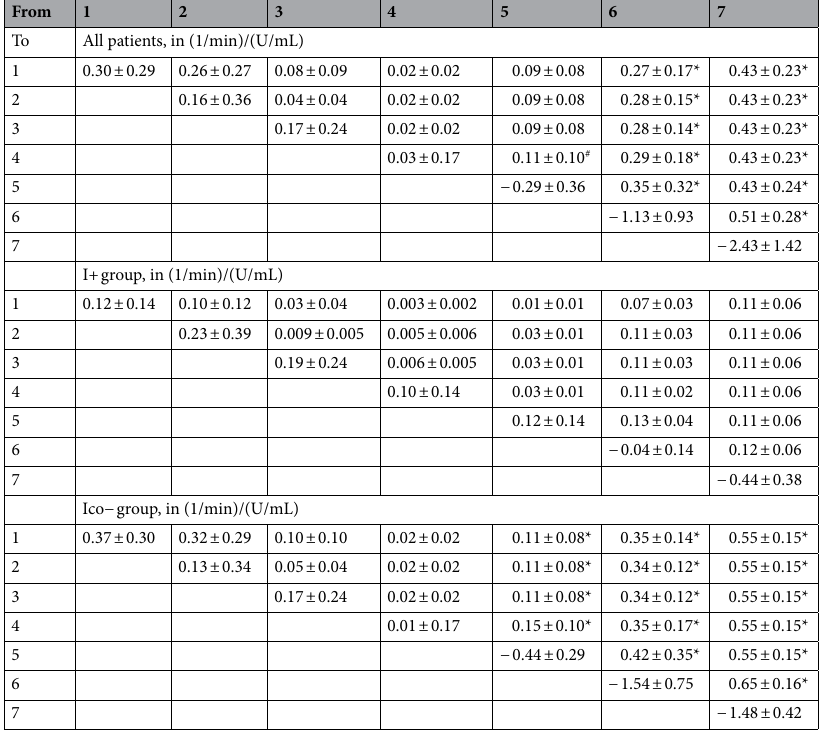
Table 3. Mean ± SD values of appearance rate constants r which hydrolysis of polymer from jth fraction leads to the increase of molar mass in fraction ith estimated for all patients (All, n = 11) and for Ico+ (n = 3) and Ico− (n = 8) groups. * p < 0.05 and # 0.05 < p < 0.1 for difference i versus r i according to post-hoc Tukey